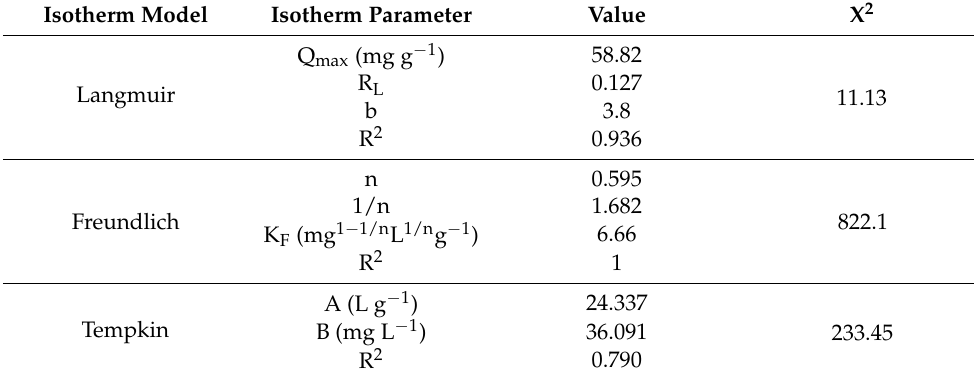
Table 5. Factors of isotherm models and error